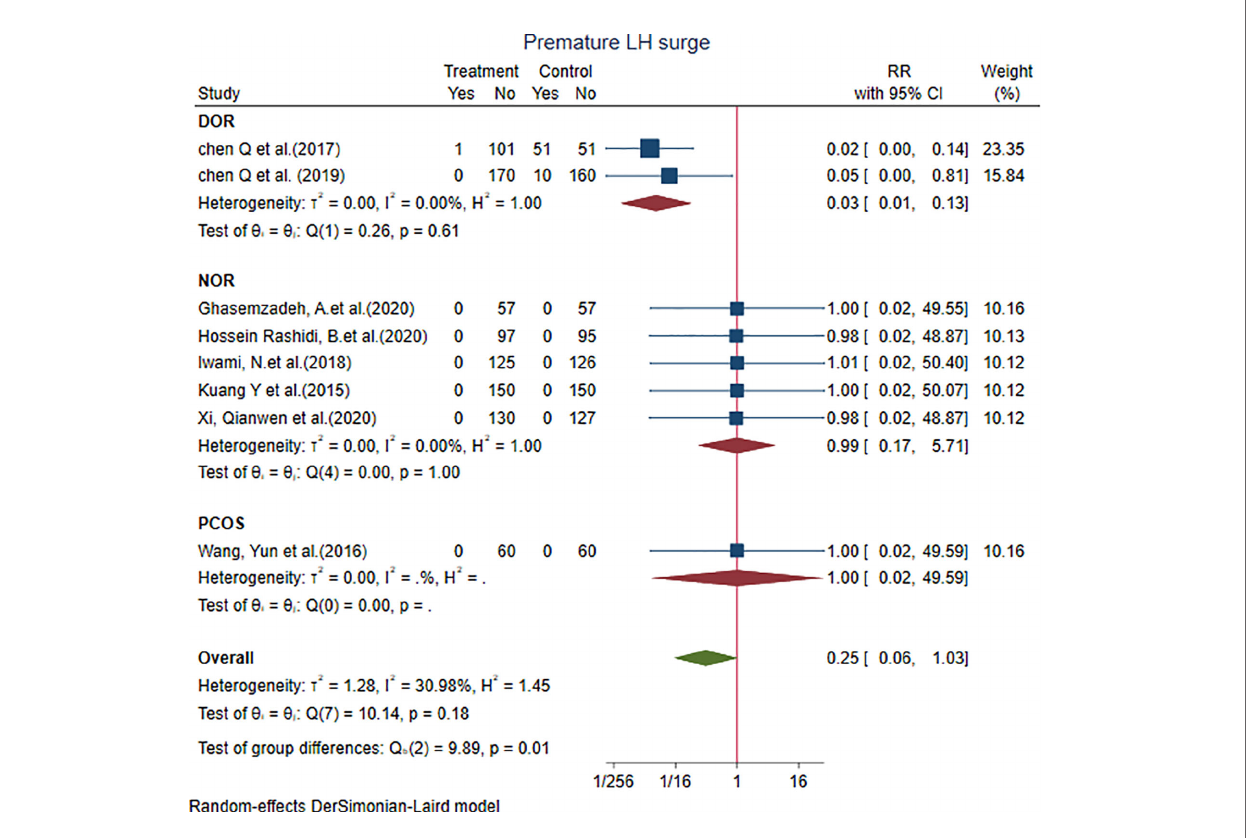
FIGURE 3 | Forest plot of studies of premature LH